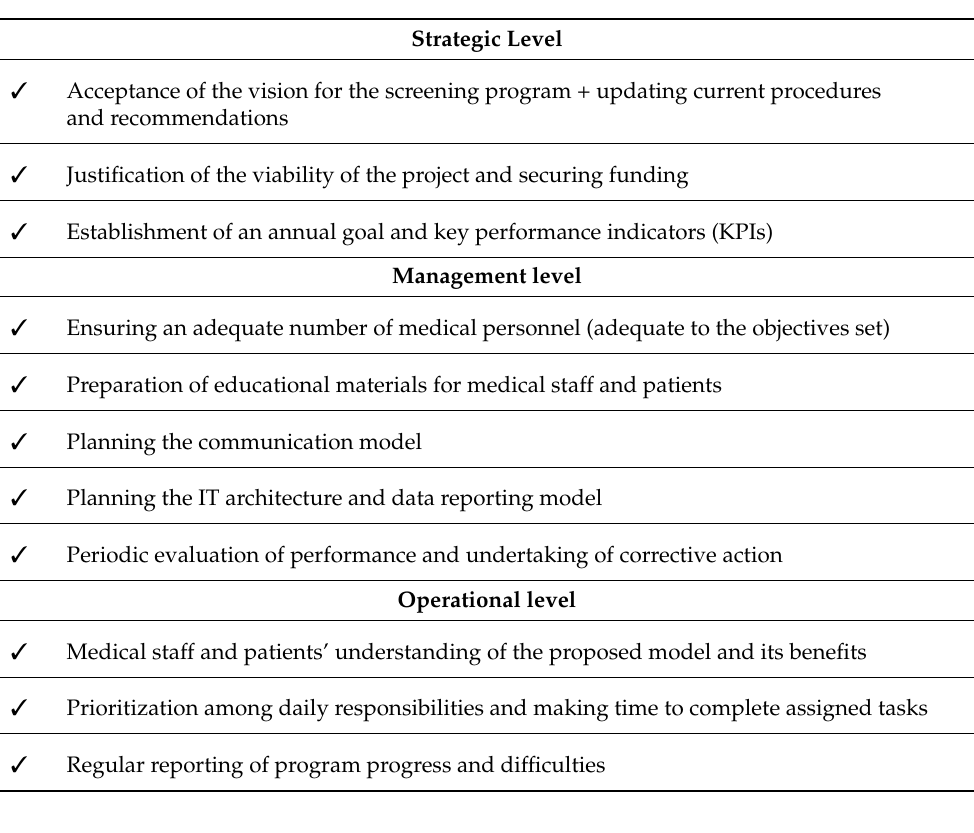
Table 11. Corrective action for the public cervical-cancer-screening